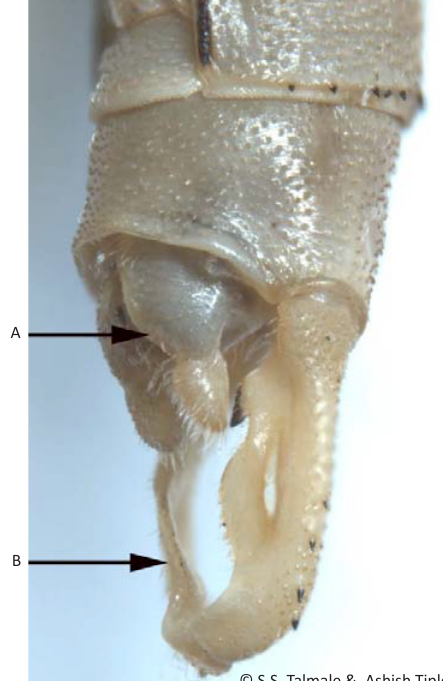
at the sides, the dorsal black is expanded subapically on segments 2–7, completely ringing the latter segment; anal appendages (Image 4) creamy white tipped with black; superiors one and a half times the length of segment 10, forcipate, apices rounded at the ends, curling in to meet each other, coarsely spined along the outer border, furnished at the junction of basal and middle thirds with a robust inner spine which is followed by the usual scale like expansion, which occupies rather more than the middle third of the appendage and is